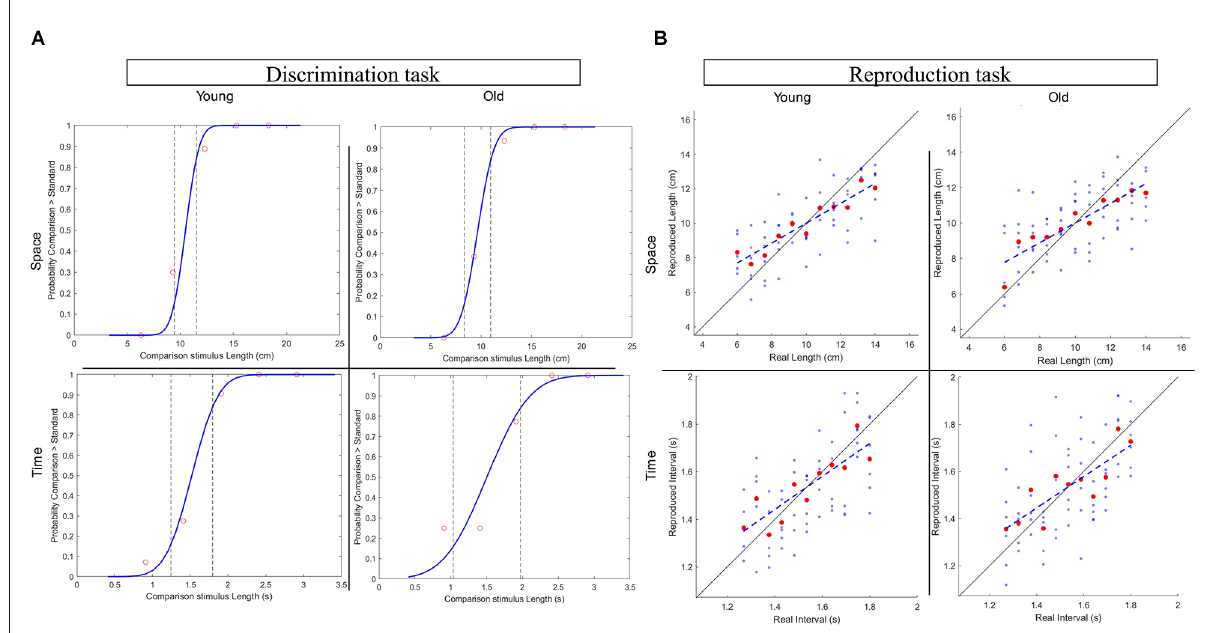
FIGURE2 (A) Representative subjects’ plots for the Discrimination task in the spatial and temporal conditions from the two age groups. (B) Representative subjects’ plots for the Reproduction task in the spatial and temporal conditions from the two age